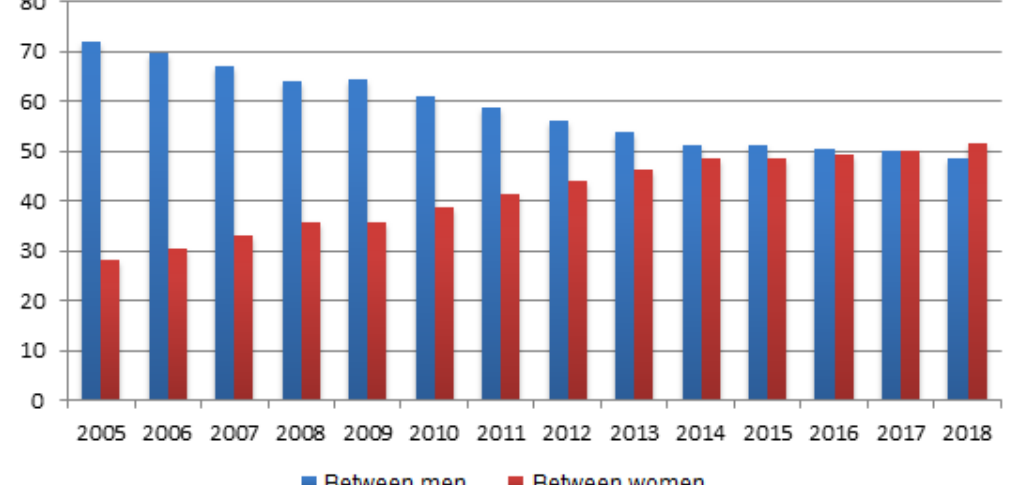
Figure 2. Evolution of same-sex marriages in Spain (%). 2005–2018. Source: graph based on the natural movement of the population (NMP).